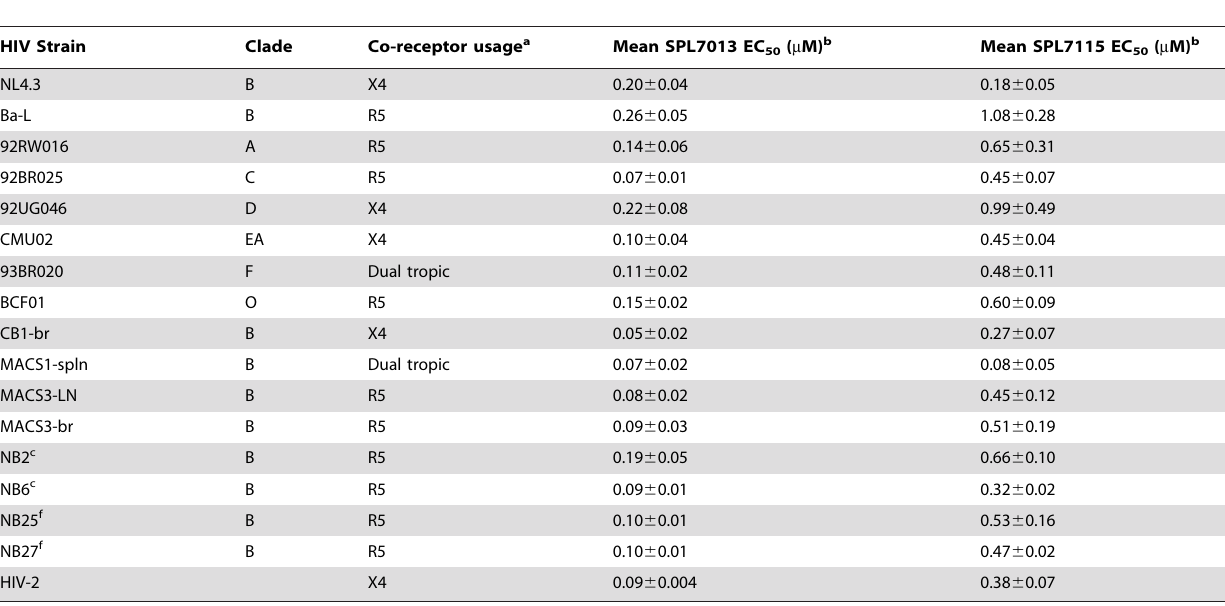
Table 1. SPL7013 and SPL7115 have broad-spectrum activity against HIV-1 strains and HIV-2 as determined in TZM-bl cells.